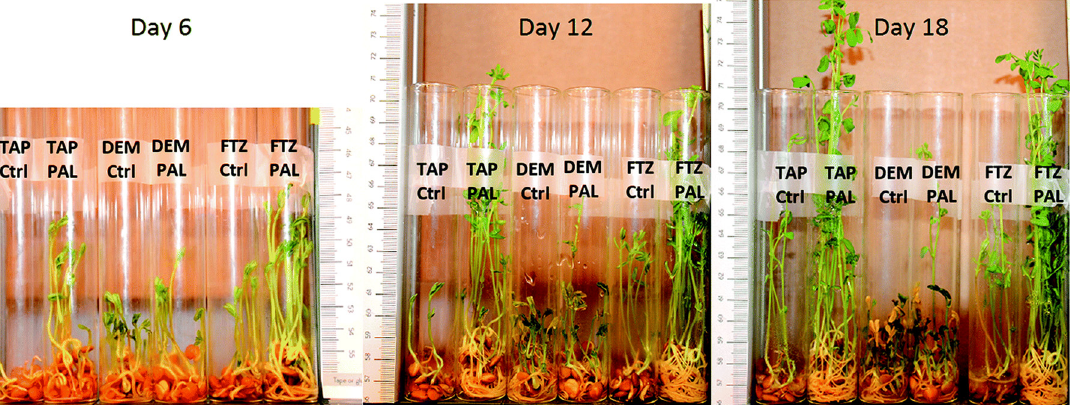
Figure 7. The effect of CAP-treated tap water on lentil seeds’ seedling. Pictures showing lentil seeds and seedlings on days 6, 12, and 18 after treatment. TAP: tap water, DEM: demineralized water, FTZ: liquid fertilizer, Ctrl: control, PAL: plasma activated liquid [59].